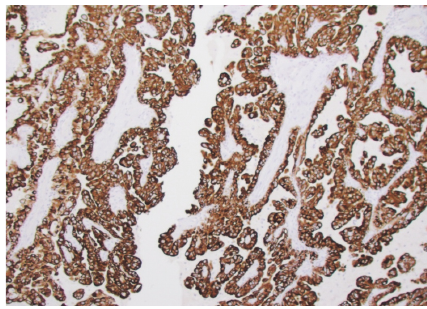
Figure 7: Diffuse membranous positivity to CK7 immunostain.